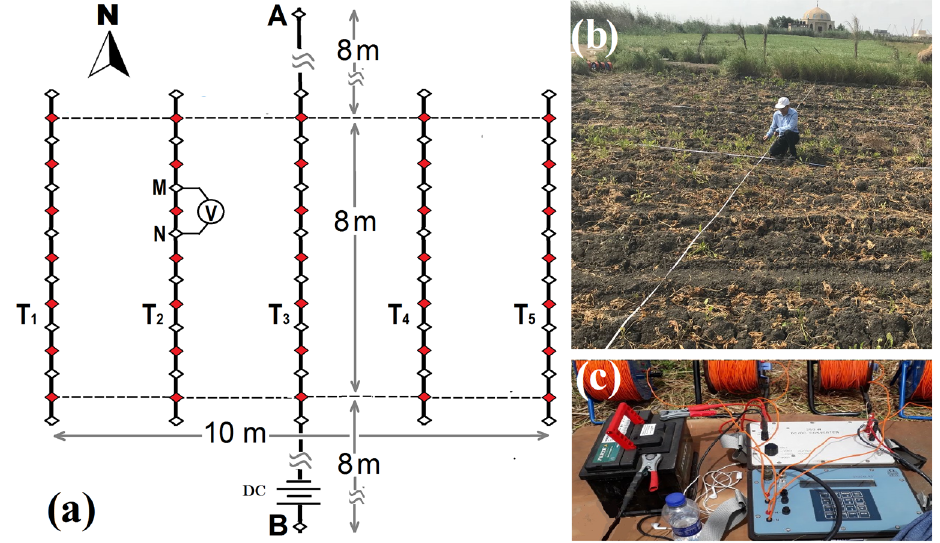
Figure 5. ( a ) Grid pattern used to conduct the apparent resistivity gradient (RG) survey, measure- ments were recorded at the midpoint, denoted by red between the two potential electrodes, ( b ) laying out the grid in the field, and ( c ) instrument used for measuring resistivity (SYSCAL-R2).